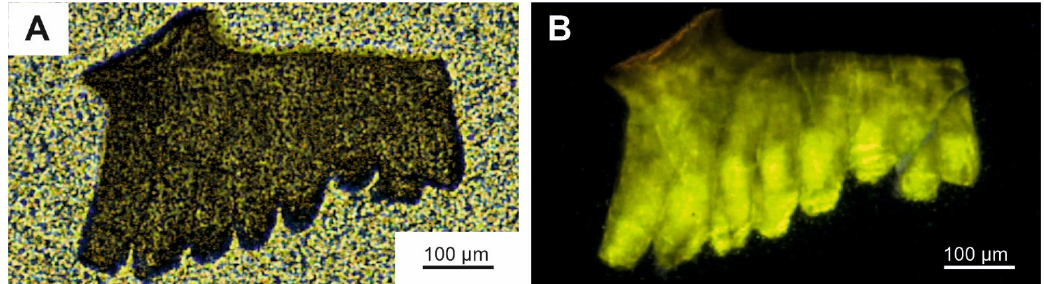
Figure 4. Lower Triassic (Dienerian) Neospathodus conodont element from Spitsbergen (studied for elemental and isotope composition by Wierzbowski et al. [132]), characterized by the low conodont colour-alteration index (CAI = 1). ( A ) Transmitted light image of the crown. ( B ) Intensive, yellow luminescence of the same area observed during the hot cathodoluminescence study.